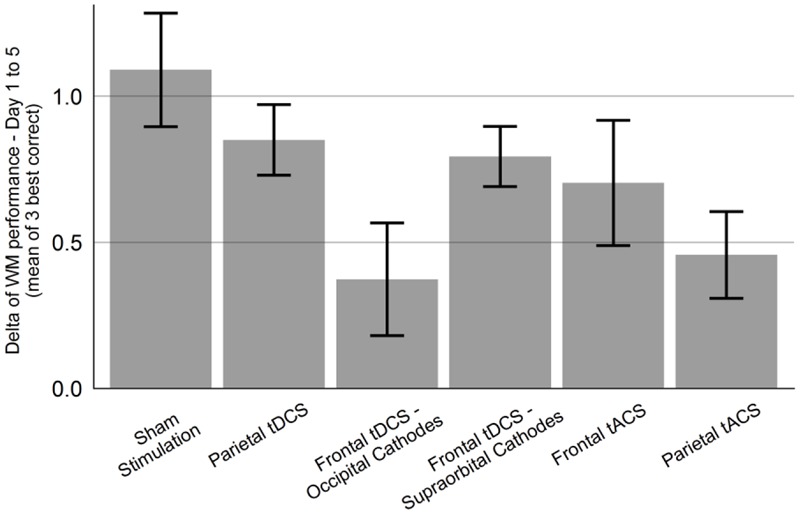
The groups’ difference in WM performance between first and last session. All six experimental groups improved their WM performance from first to last session, measured as mean of the three highest-level correct items of each session. Error bars show standard error of the mean.